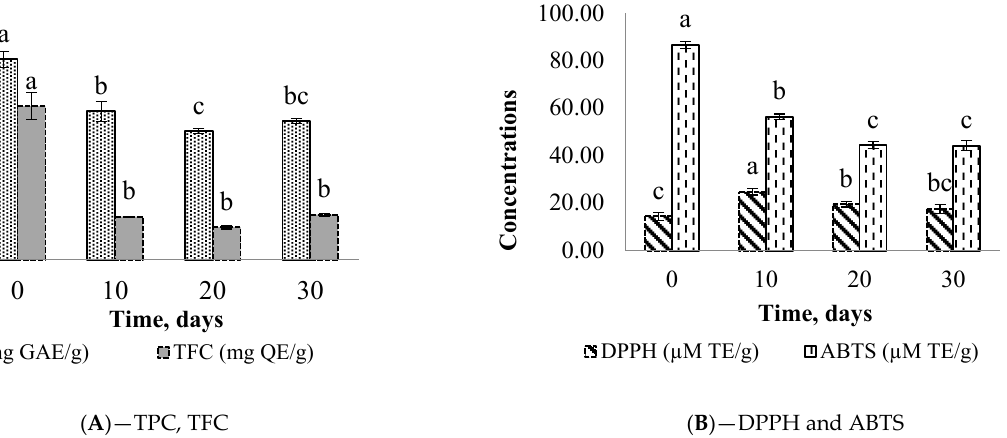
Figure 1. Storage stability of TPC, TFC ( A ), DPPH, and ABTS ( B ) from the microencapsulated extracts of Ziziphus mauritiana. Different letters (a–c) for the same parameter show a significant difference between the means at 0.05.